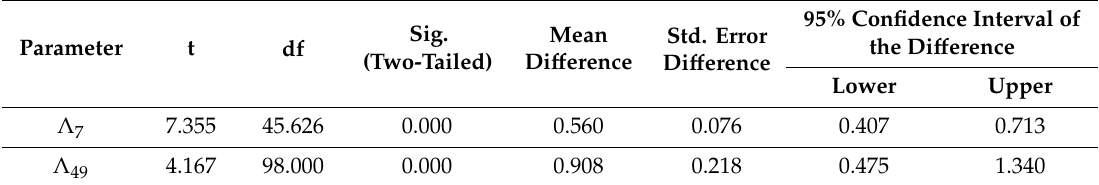
Table 7. Independent samples t -test for the groups of the H subjects and CHF patients (ECG method).